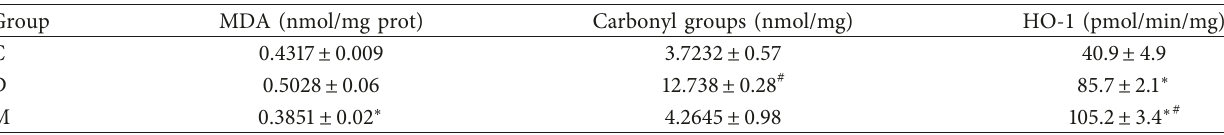
Table 2: Levels of MDA and carbonyl groups in liver mitochondria from different treatments.